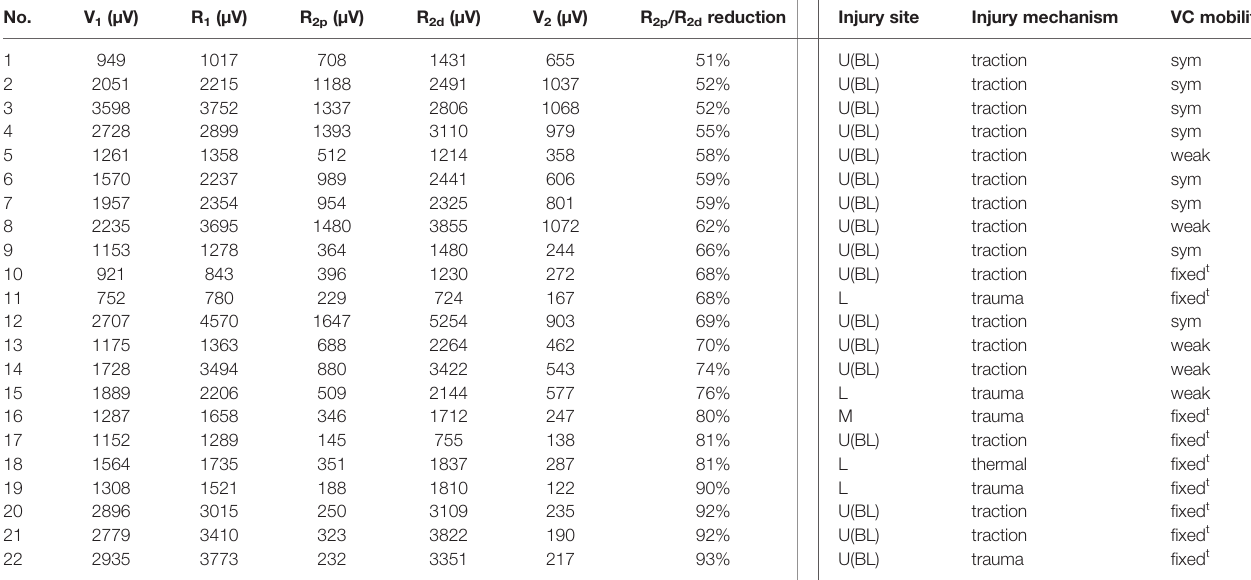
TABLE 3 | Intraoperative EMG signals and mechanism of nerve injury in the RLNs without complete LOS (detectable injury site and R 2p /R 2d reduction >50%).